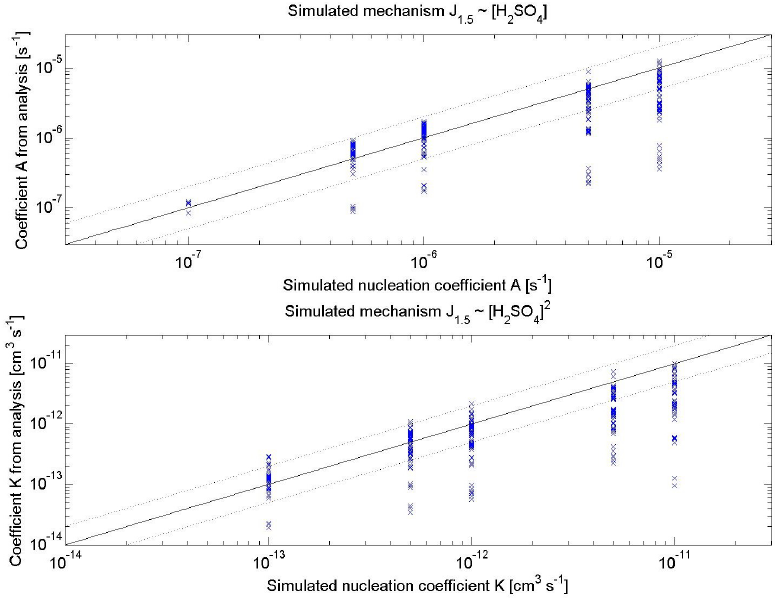
Fig. 8. Comparison of predicted and simulated nucleation coefficients for (a) activation nucleation events only and (b) kinetic nucleation events only. Shown are also 1:1 line (solid) as well as 1:2 and 2:1 lines